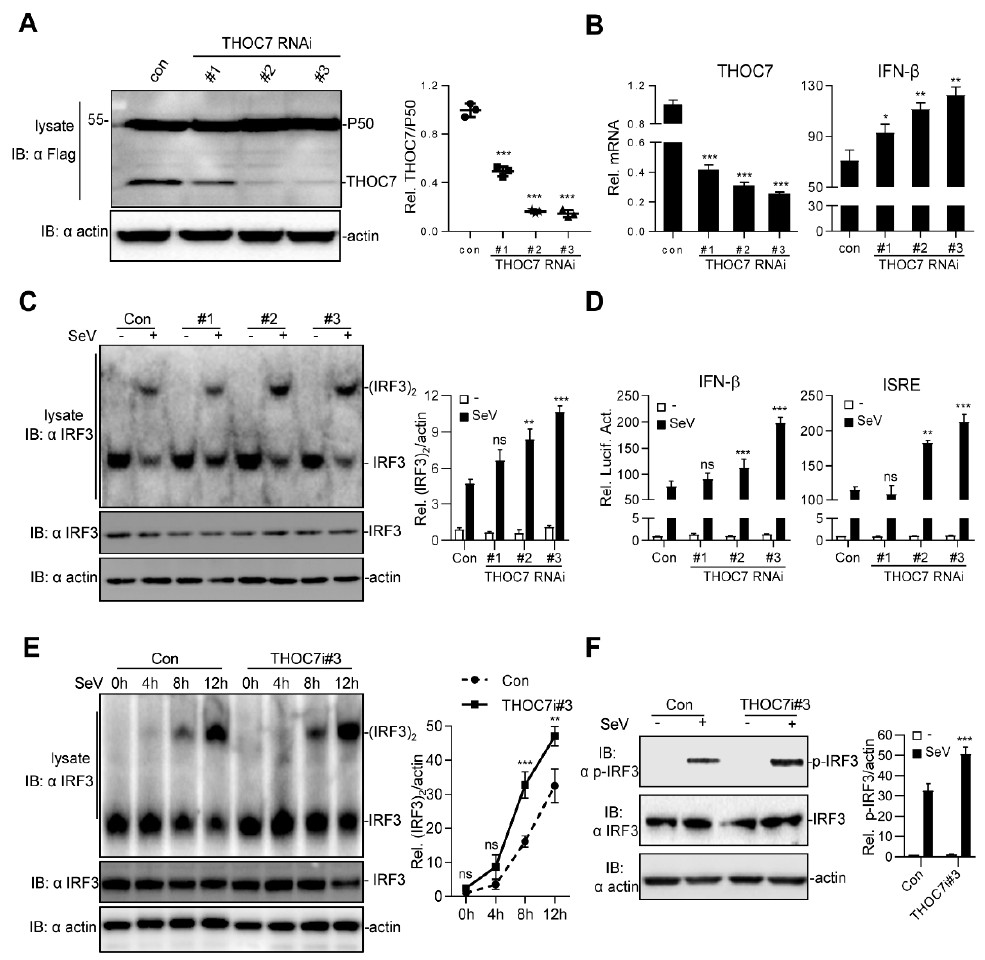
Figure 2. Knockdown of THOC7 leads to up-regulation of type I IFNs. ( A ) Immunoblot analysis following knockdown of transfected THOC7 in 293T cells transfected with THOC7-specific RNAis (2 µ g), Flag-THOC7 plasmid (1 µ g), and Flag-P50 (0.1 µ g, as an internal control protein). ( B ) Real-time PCR of knockdown of exogenous THOC7 (left panel) or IFN- β mRNA (right panel) in 293T cells transfected with control RNAi or RNAis against THOC7 (4 µ g). ( C ) Native PAGE analysis of IRF3 dimerization in 293T cells transfected with THOC7-specific RNAis (4 µ g) and treated with SeV for 12 h. ( D ) Luciferase assays of 293T cells transfected with ISRE or IFN β luciferase report plasmid (100 ng/well) with pRL-TK (50 ng/well), as well as THOC7 RNAi or control (0.5 µ g/well). ( E ) IRF3 dimerization analysis of THOC7 RNAi#3 in gradient times of SeV treatment. Similar experiments were performed as ( C ) except with an increased time of SeV treatment. ( F ) Effects of knockdown of THOC7 on SeV-induced phosphorylation of IRF3. 293T cells were transfected with control RNAi or THOC7 RNAi#3 and infected with SeV for 10 h, followed by immunoblotting analysis with the indicated antibodies. Quantification of western blotting bands ( A , C , E , F ) from three independent experiments was performed with Image J software. Error bars indicate SD. n = 3. *, p < 0.05; **, p < 0.01; ***, p < 0.001; ns, no significant difference.